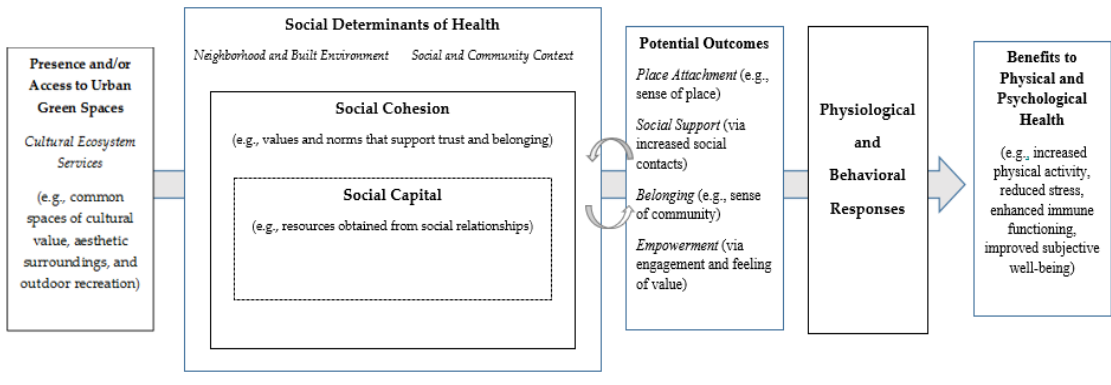
Figure 1. Conceptual framework to illustrate the relationship between cultural ecosystem services from urban green spaces and social cohesion (as a social determinant of health) with social and health outcomes.